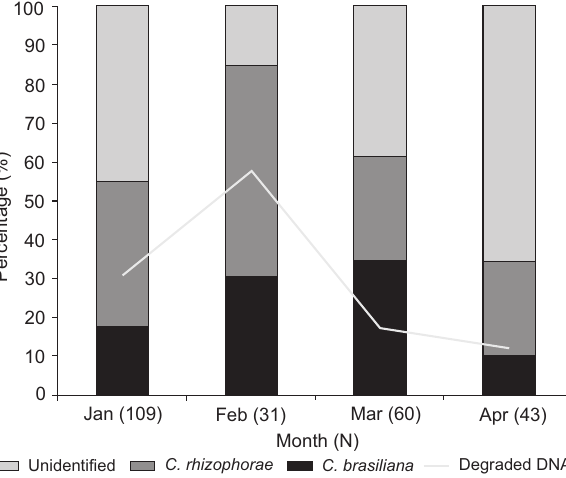
Figure 4. Percentage of C. rhizophorae , C. brasiliana and an uni- dentified species of oyster detected from January-April 2010 from collectors installed in the region of Cabaraquara (Guaratuba Bay, Brazil). The line graphic traces the percentage of specimens that could not be identified due to inadequate fixation and degraded DNA. The total number of specimens collected and processed each month is given in parenthesis following the